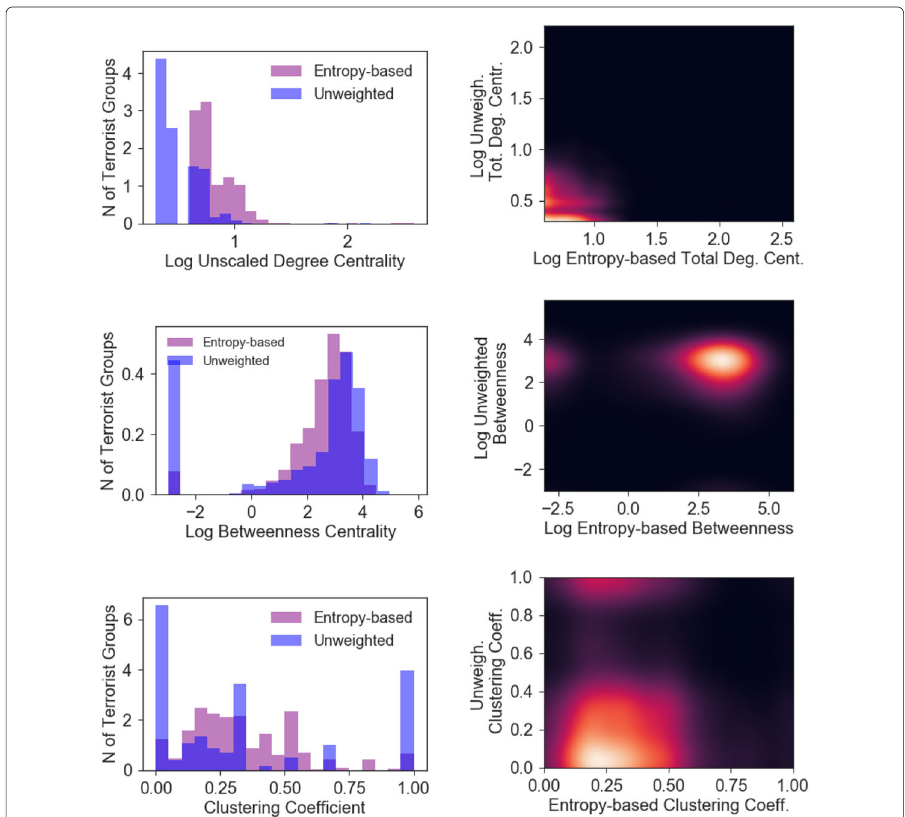
Fig. 4 Histograms (20 bins) and 2D Kernel Density Estimation of Log Unscaled Total Degree Centrality, Log Betweenness Centrality and Clustering Coefficient of Terrorist Groups across both approaches 2D Kernel Density Estimations are performed through regular grids made of 500 bins for each